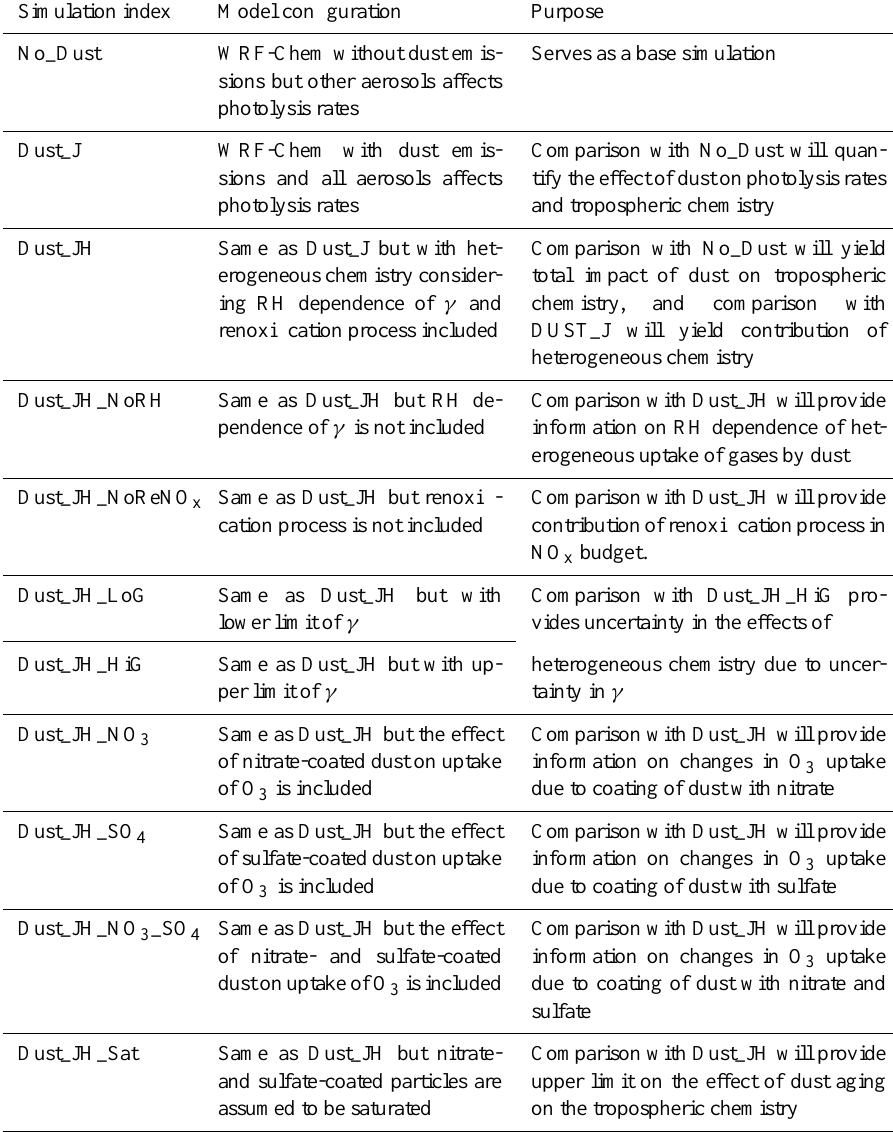
Table 2. Simulation designs used in this study and their purpose are